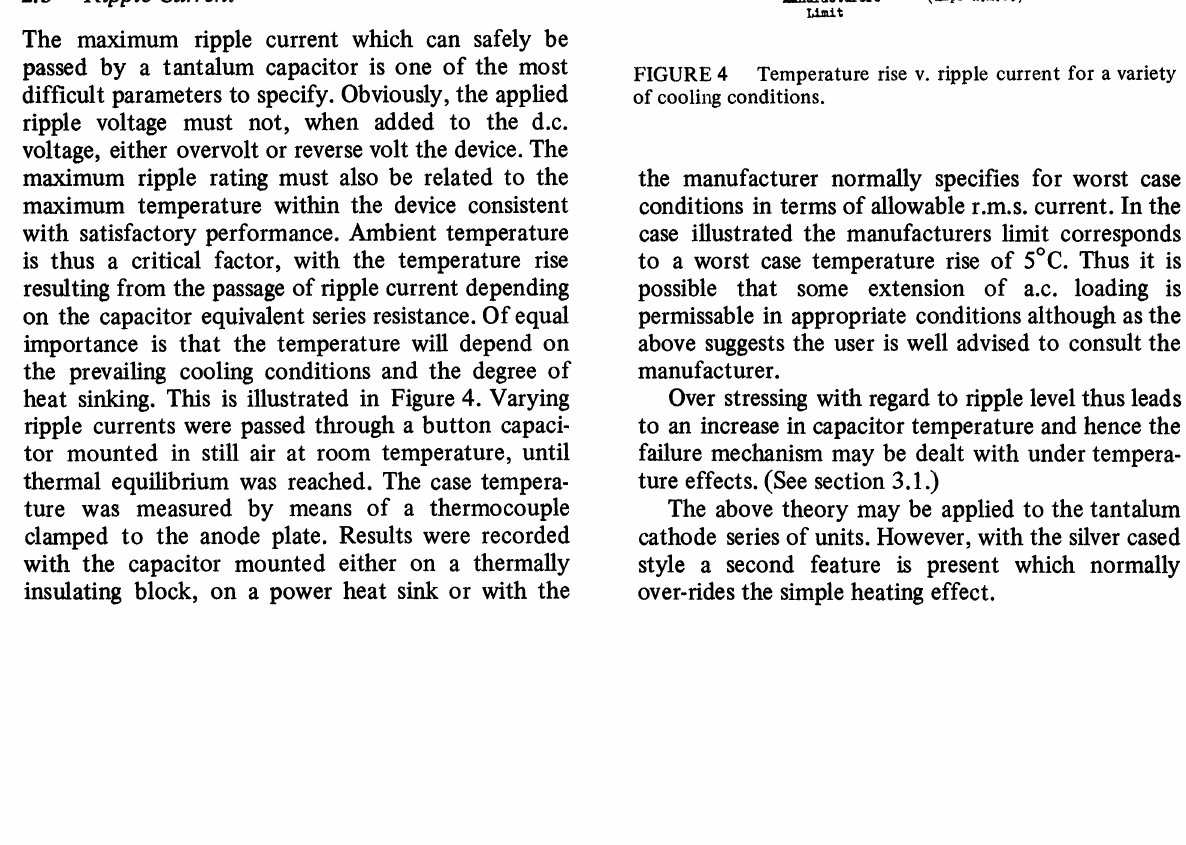
Temperature rise v. ripple current for a variety of cooling